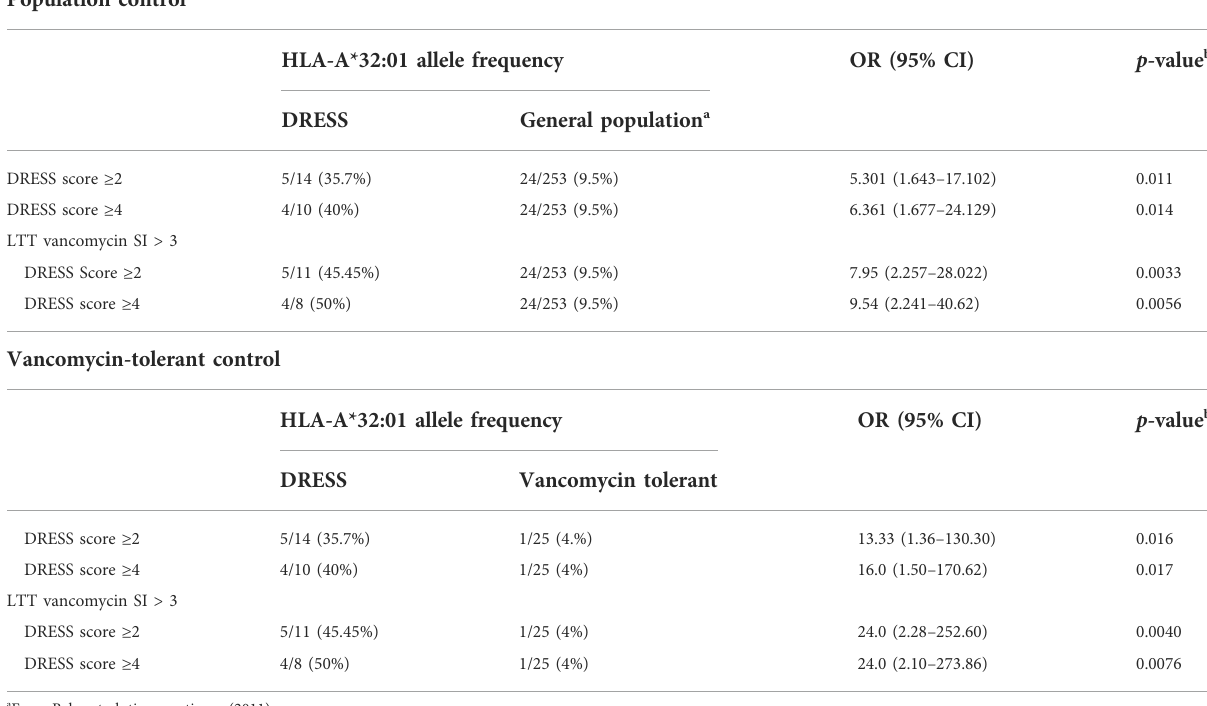
TABLE 3 HLA-A*32:01 frequency in vancomycin-induced DRESS cases as compared to population controls and vancomycin-tolerant controls. Population